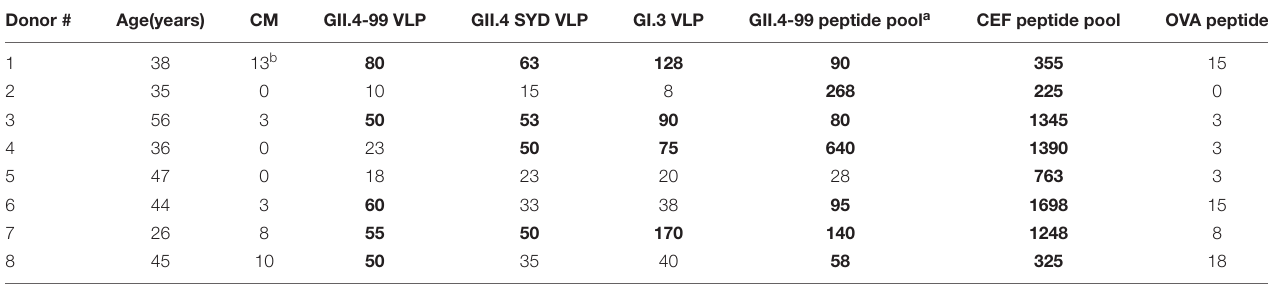
TABLE 1 | T cell interferon gamma (IFN- γ ) responses to NoV